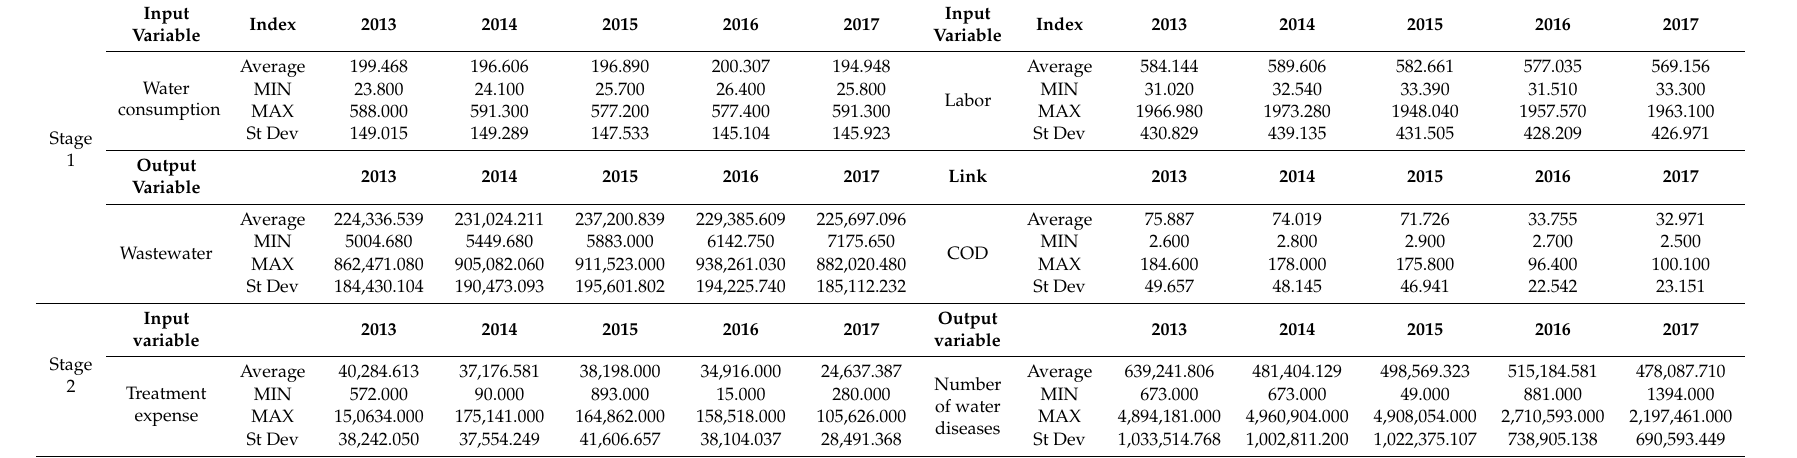
Table 2. Statistical analysis of input–output indicators from 2013 to